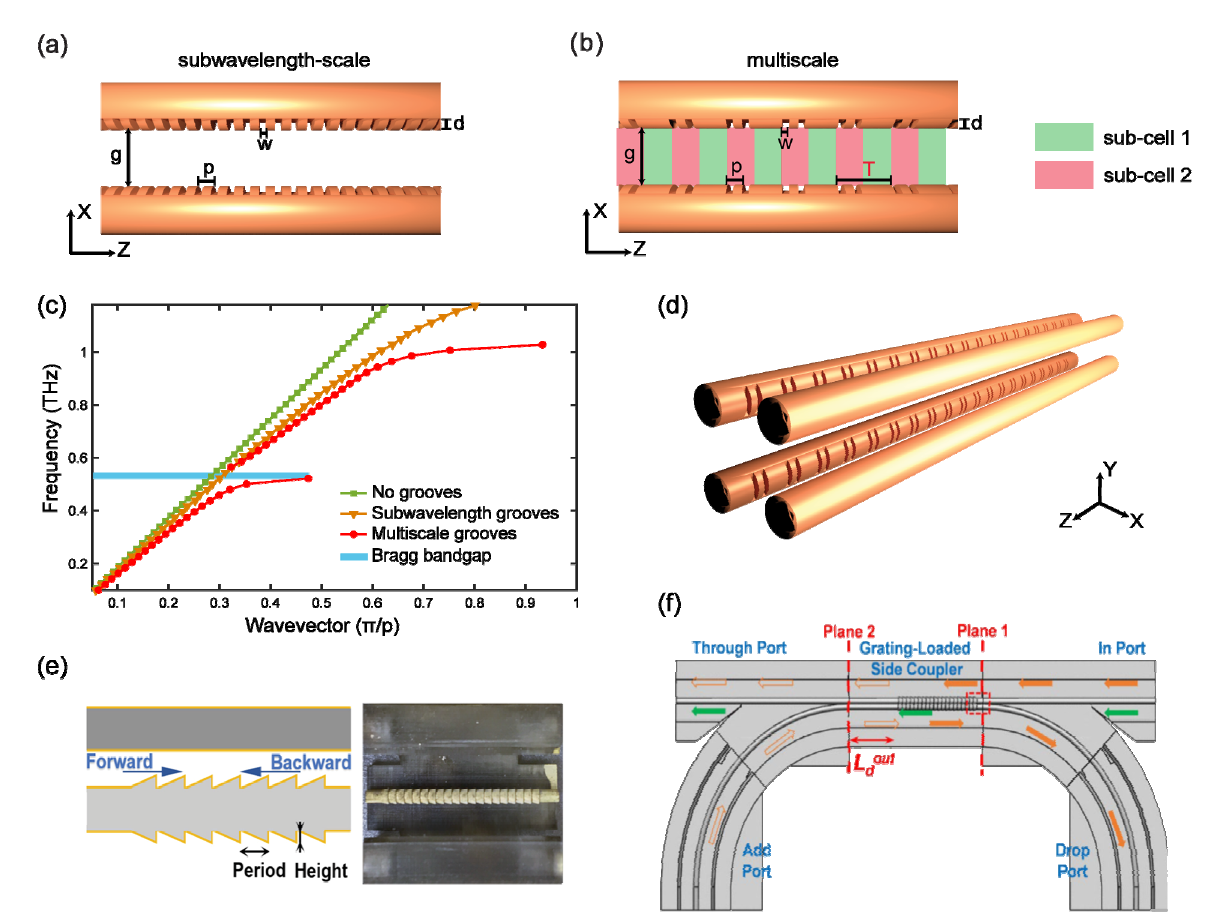
Figure 4. THz metal − wire signal processors realized by engineering the wire surfaces. ( a ) Schematic of the TWWG (a wire radius r = 127 µm, an air gap g = 300 µm) with subwavelength-scale periodic grooves, adapted from [41]. Geometry of the grooves: width w = 35 µm, depth d = 40 µm, and period p = 80 µm. ( b ) Schematic of the TWWG with multiscale grooves. This structure results from superimposing a wavelength-scale periodic modulation with a period of T = 280 µm onto the subwavelength-scale periodic grooves in ( a ), adapted from [41]. ( c ) Simulated dispersion relations of the plain TWWG (in green), and TWWGs with subwavelength-scale (in orange) and multiscale periodic grooves (in red), adapted from [41]. ( d ) Schematic of the FWWG with integrated multiscale-structured Bragg gratings, adapted from [41]. ( e ) Schematic of the Bragg grating achieved via 3D-printing, adapted from [39]. The grating contains 20 periods featuring a period Λ = 1.03 mm and a grating height H = 0.21 mm. ( f ) Schematic of the four-port add-drop multiplexer realized via 3D printing, adapted from [39]. It is composed of two Y splitters and a 35-mm-long grating-loaded side coupler.